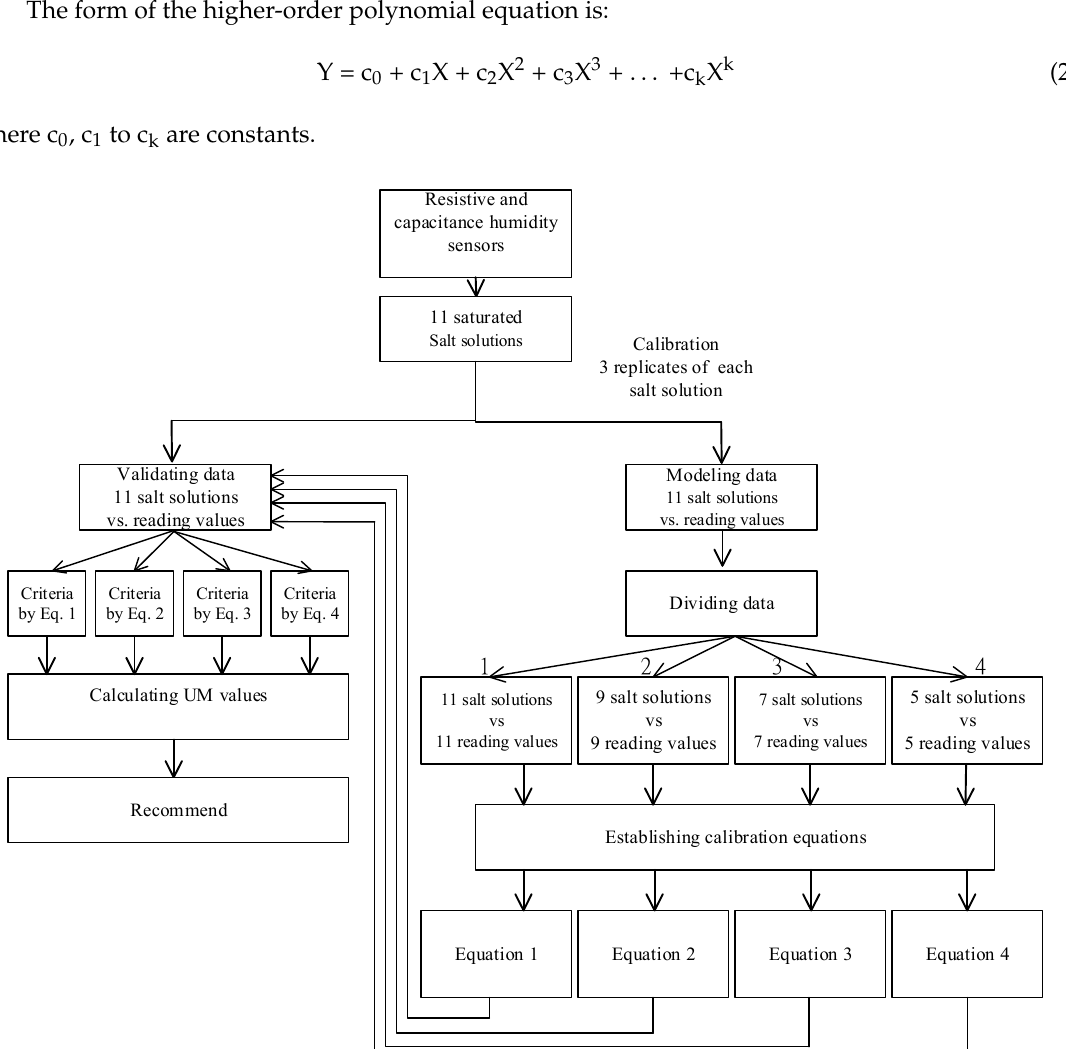
Figure 1. The experimental design and flowchart of data analysis.